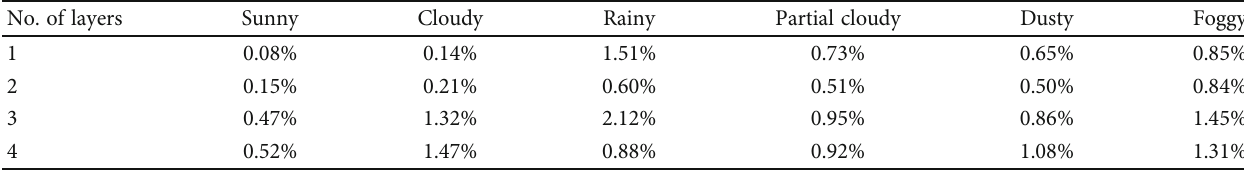
Table 2: Cv (RMSE) results of hourly forecast of PV power output using LSTM with four di ff erent hidden layers. No. of layers